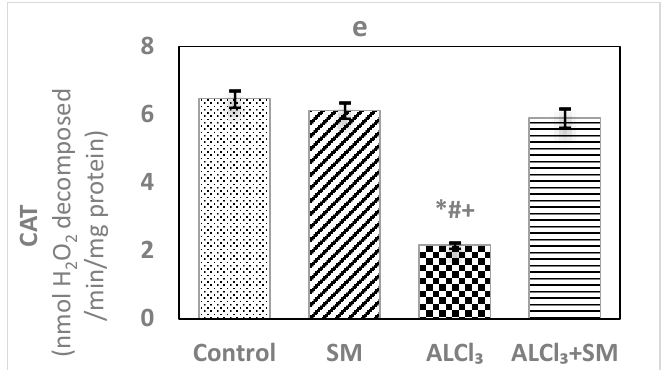
Figure 1. Levels of ( a ) malondialdehyde (MDA), ( b ) nitric oxide (NO) and ( c ) reduced glutathione (GSH), and activities of ( d ) superoxide dismutase (SOD) and ( e ) catalase (CAT) in hippocampal tissues of control and experimental groups of rats. Values are expressed as mean ± standard error of mean (SEM) ( n = 6). Comparisons are as follows: * p ≤ 0.05, significantly different from Control; # p ≤ 0.05, significantly different from silymarin (SM); + p ≤ 0.05, AlCl 3 significantly different from AlCl 3 + SM group.